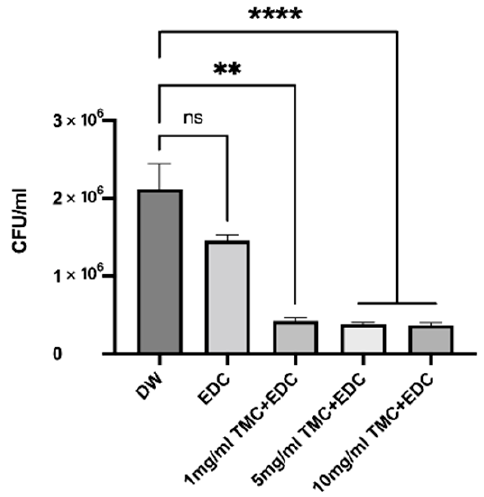
Figure 6. Colony-forming units of bacteria derived from biofilms on the dentin collagen matrix. (ns, no statistical significance; **, p < 0.01; ****, p < 0.0001.).